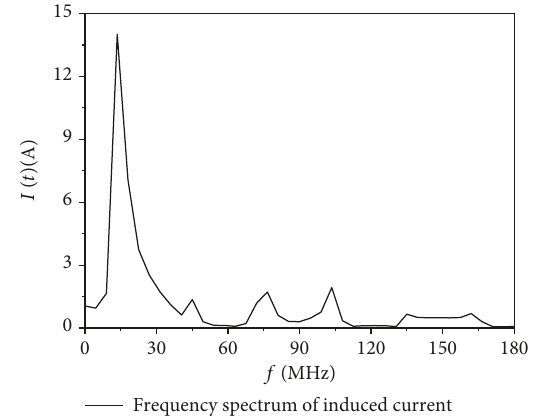
Figure 10: The frequency spectrum of induced current when L = 10 m.